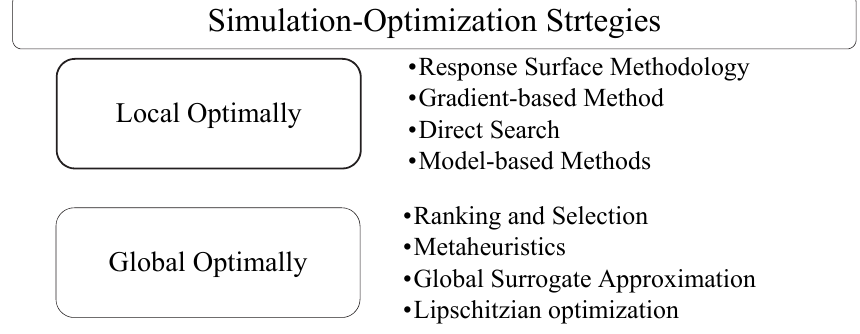
Fig. 6. Simulation optimization strategies based on locally and globally solution.